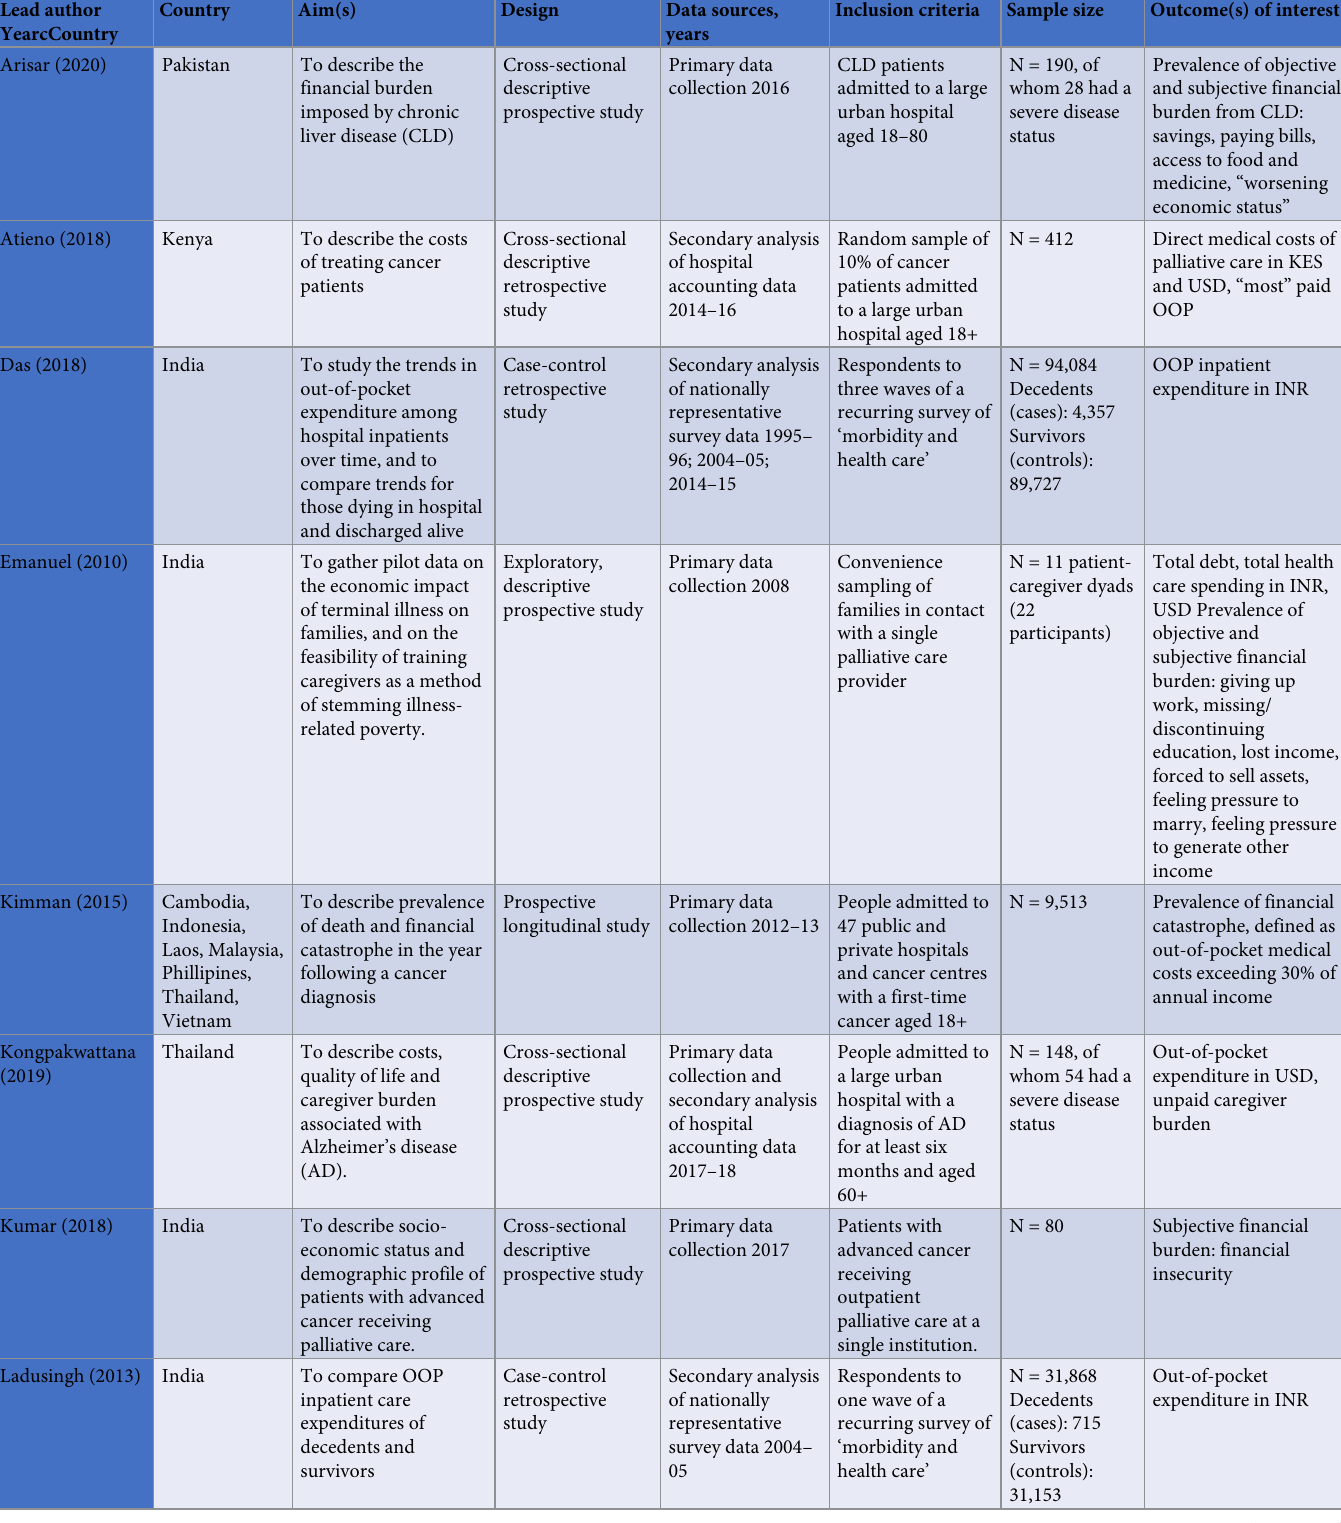
Table 1. Data extraction- all included